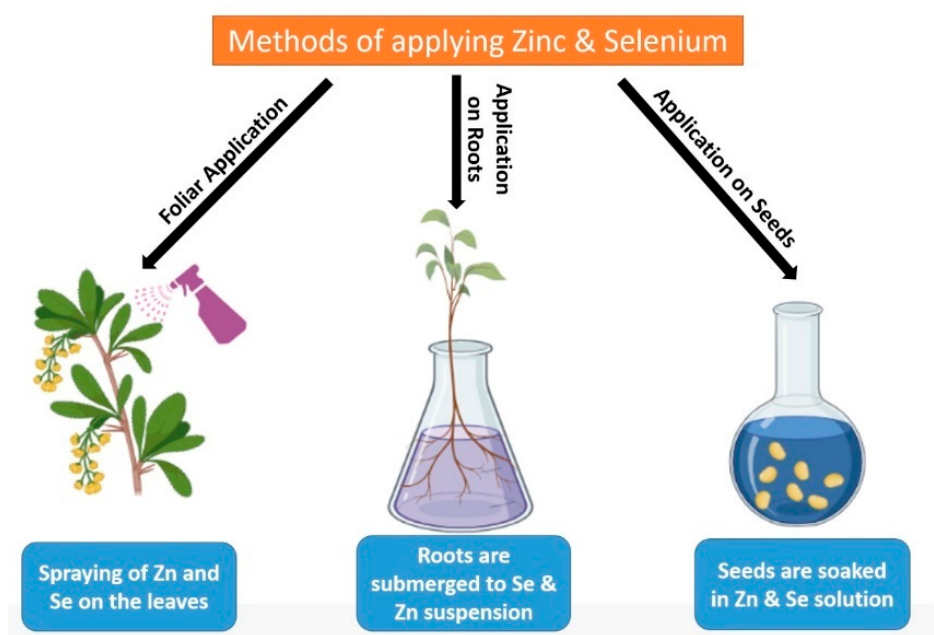
Figure 4. Methods of application of both Zn and Se in plants. Table 1. Impact of Zinc and Selenium application on plant leaves and soil.